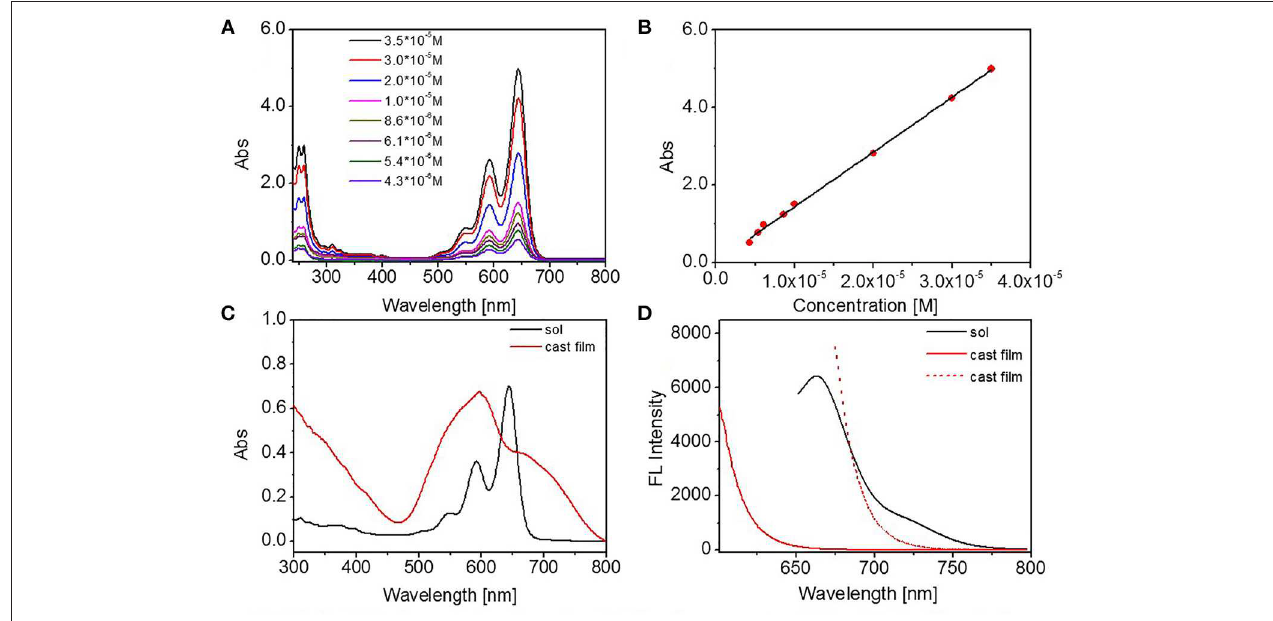
FIGURE 1 | (A) Concentration-dependent UV absorbance spectra of DUO-TDI in THF solutions, (B) The absorbance intensity at 644 nm as a function of concentration. The fitting R squared factor was 0.9966, (C) UV absorption spectra of DUO-TDI in THF solution (1.5 × 10 − 5 M) and cast film, (D) FL spectra of DUO-TDI in THF solution (1.5 × 10 − 5 M) and cast film. The excitation wavelength ( λ ex) was 644 nm for solution. And Xex = 598 (red solid line) or 672 nm (red dashed line) for cast film.